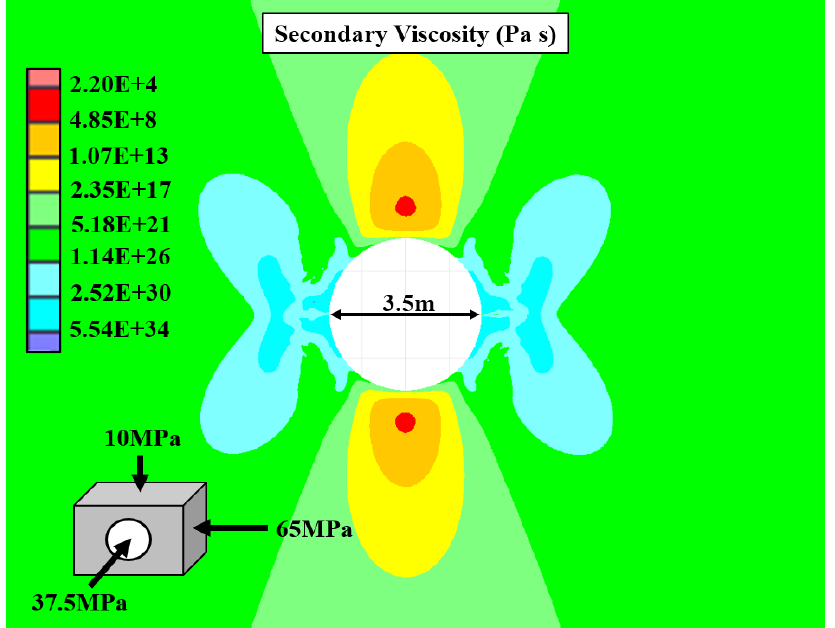
Figure 10. Instantaneous secondary viscosity contours around the 3.5 m diameter AECL URL tunnel in LdB granite.